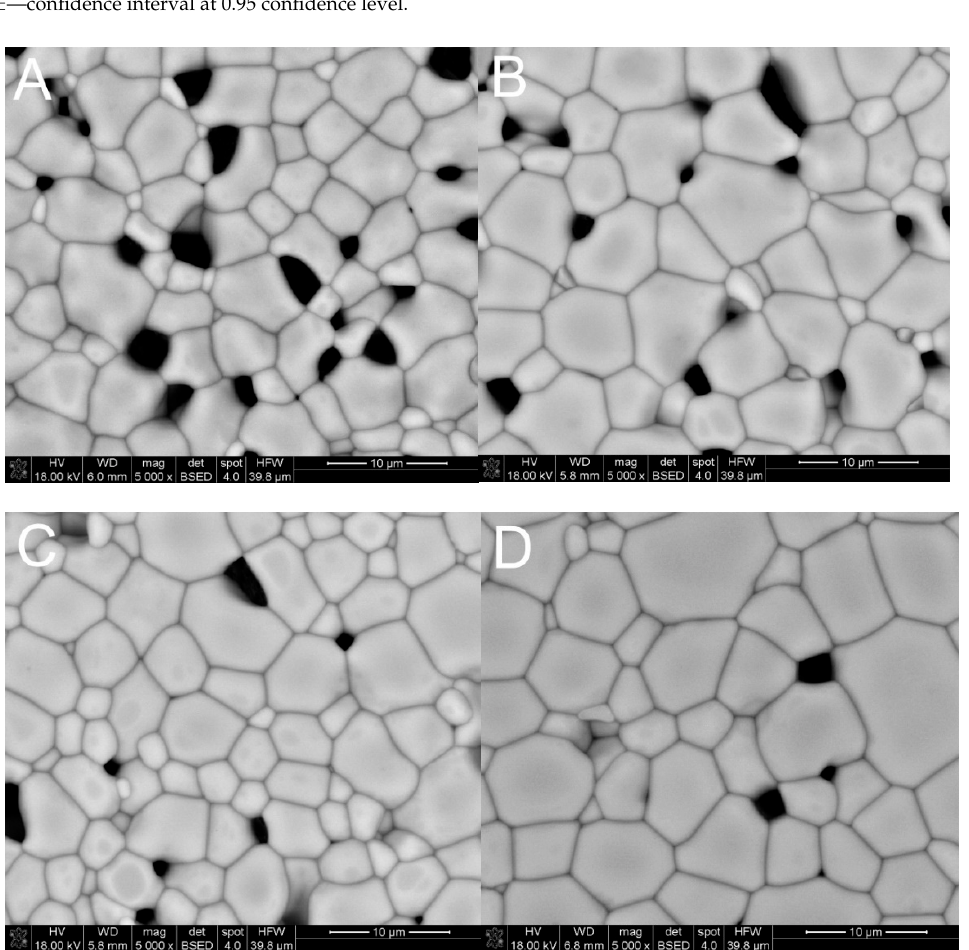
Figure 4. SEM micrographs of materials sintered at 1400 °C: ( A )—Method A, ( B )—Method B, ( C )—Method C, ( D )—Method D.